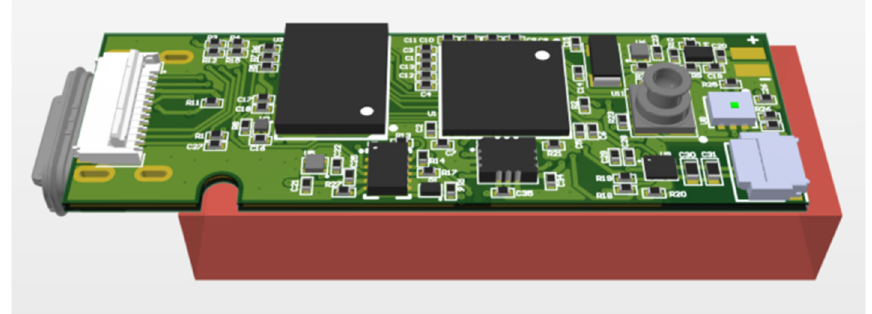
Figure 2. 3D view of the final designed PCB. The orange block represents the battery.